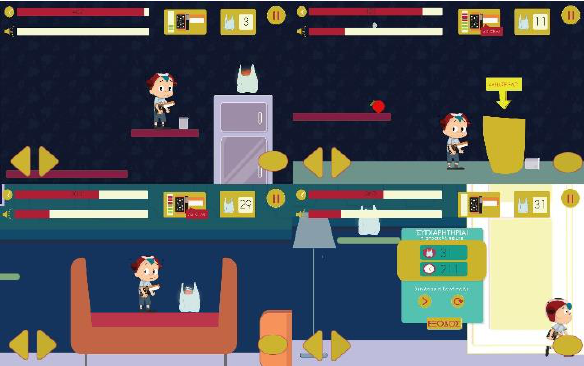
Figure 1. Screenshots of “Bag to the future” game.